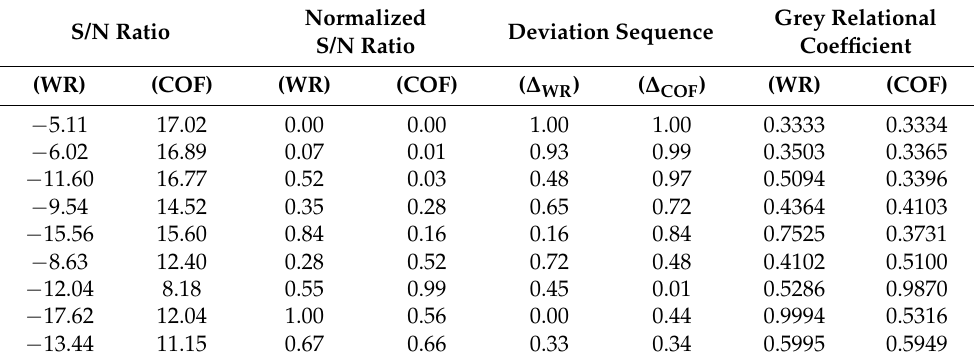
Table 4. S/N ratio, normalized S/N ratio, and grey